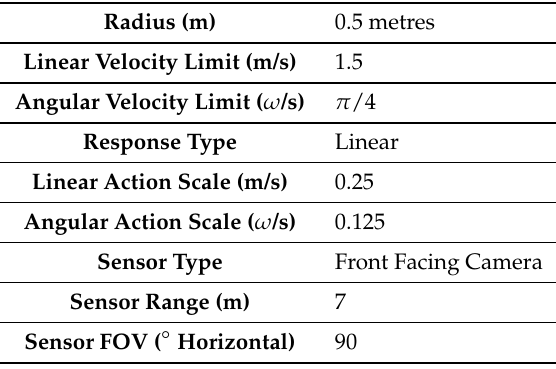
Table 3. Generic Simulated Agent